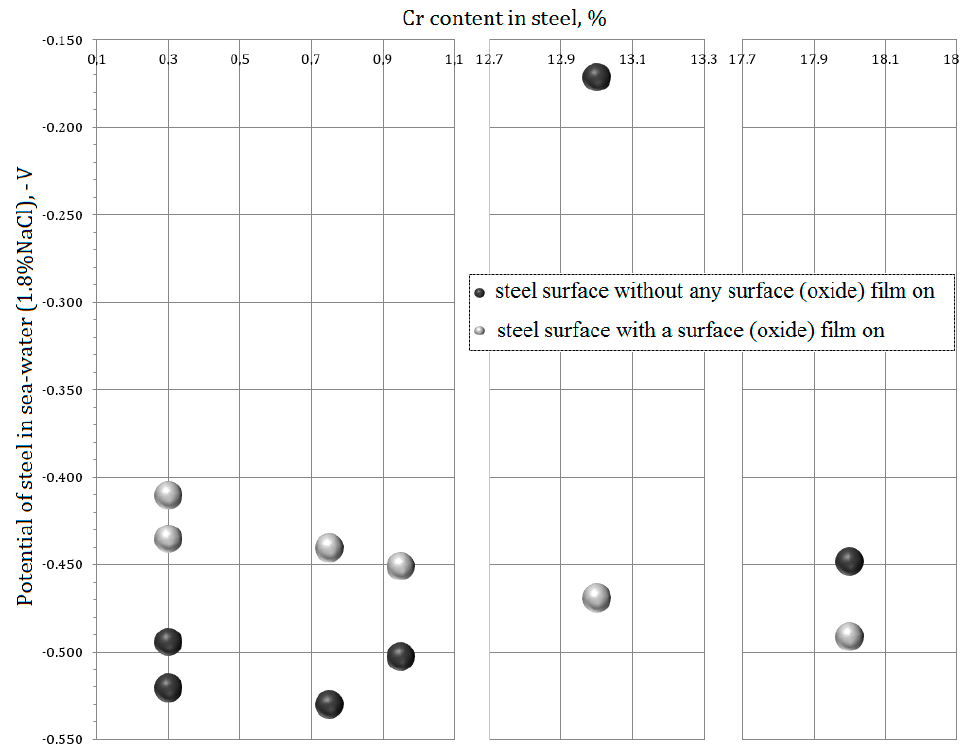
Figure 10. The relationship between chrome content and potential of seawater (1.8% NaCl)-im- mersed steel both with a surface (oxide) film and without